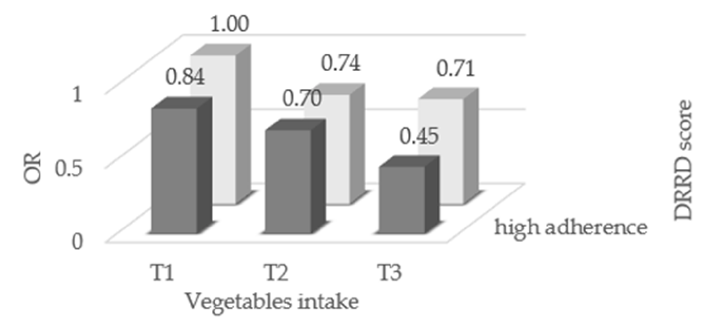
Figure 2. Odds ratios (OR) of endometrial cancer for combination of adherence to the diabetes risk reduction diet (DRRD) and consumption of total vegetables, Italy, 1992–2006. OR were derived from logistic regression models, conditioned on center and quinquennia of age, and adjusted for years of education, year of interview, body mass index, occupational physical activity, smoking status, alcohol intake, history of diabetes, total energy intake, age at menarche, parity, menopausal status, use of oral contraceptives, and use of hormone replacement